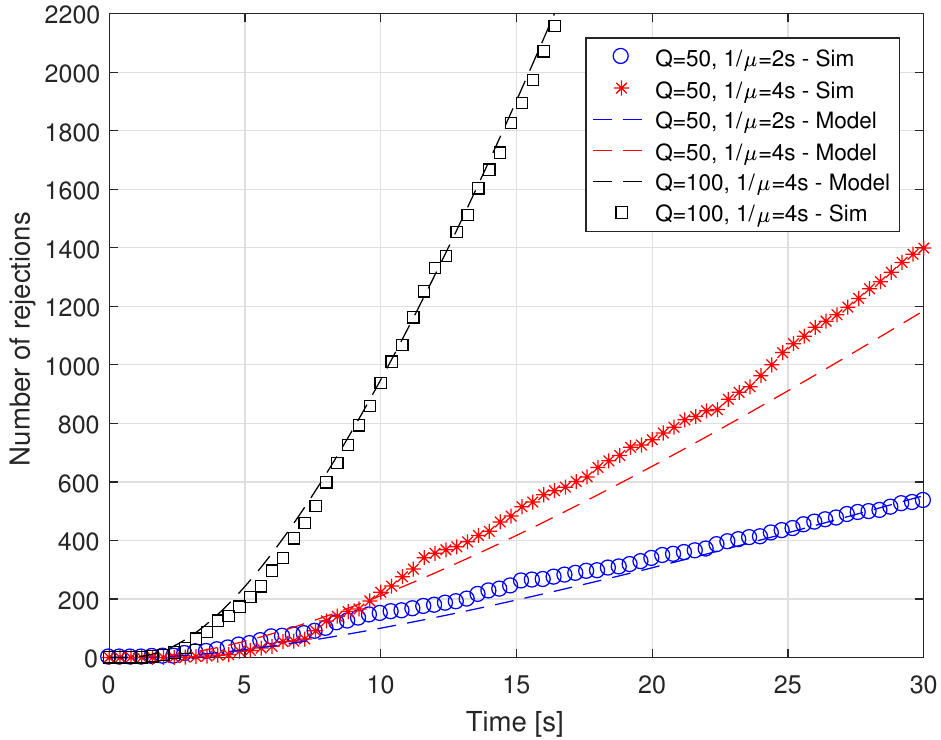
Figure 3. Rejected molecules vs. time for different values of system parameters (burst size Q and absorption time 1/ µ